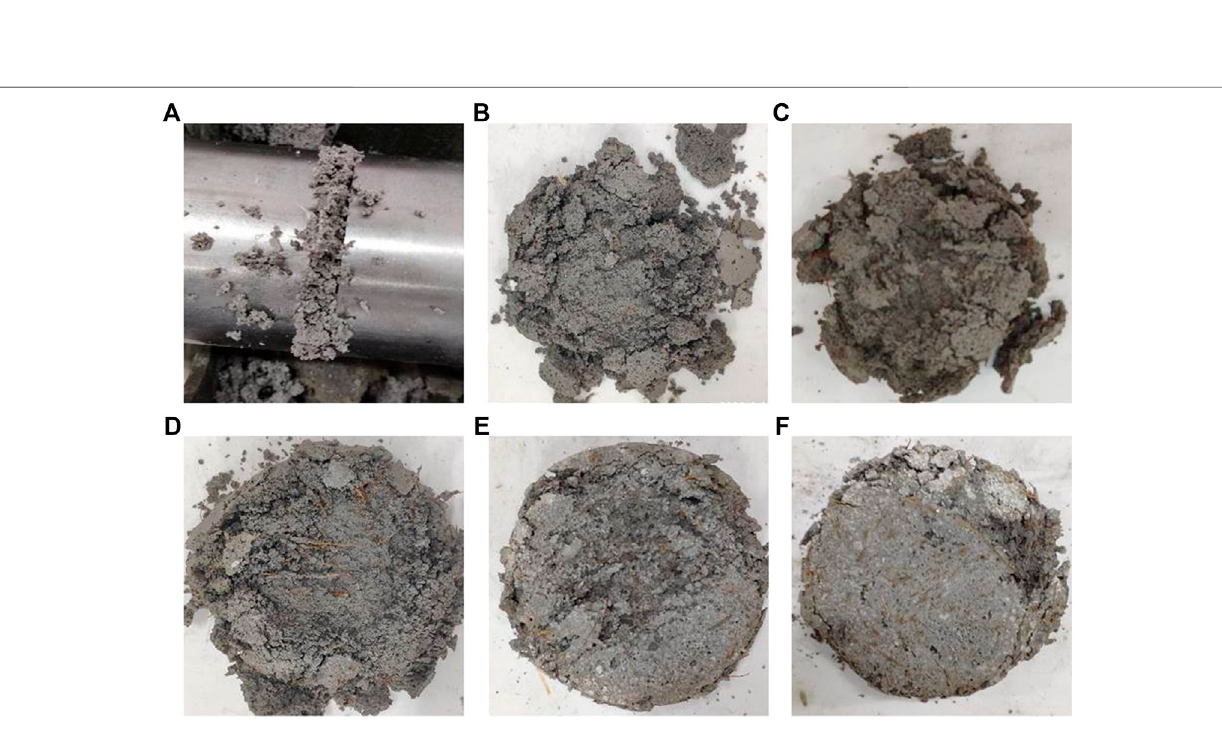
Frontiers in Materials |